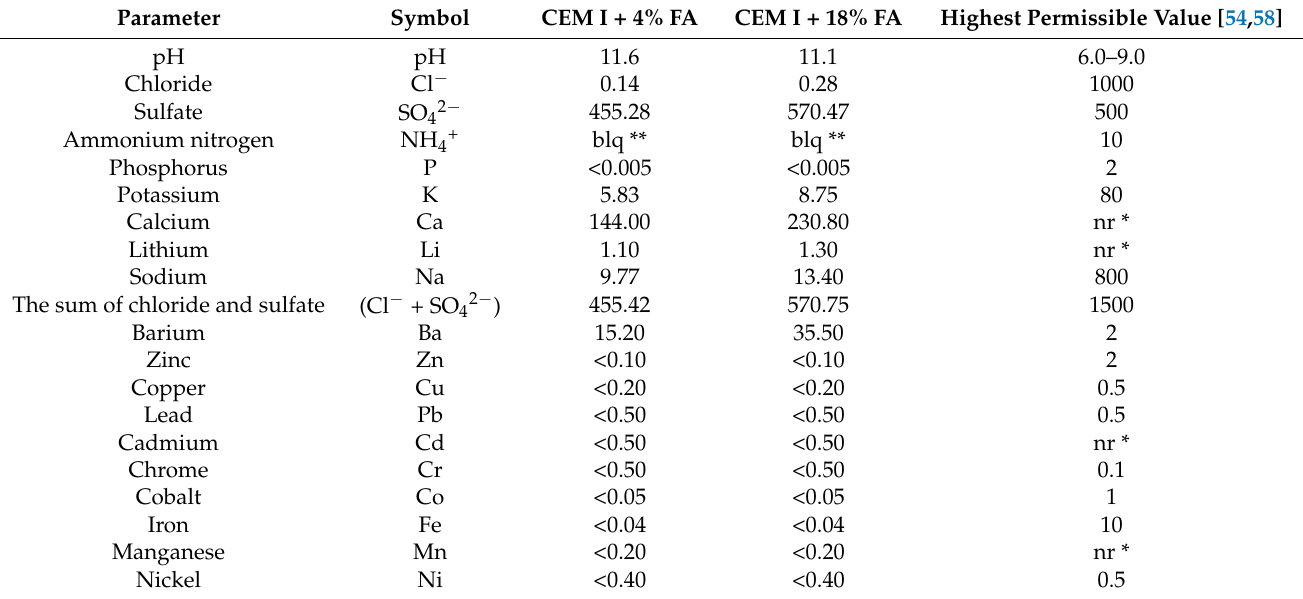
Table 5. The leachability of hazardous substances and heavy metals from cement mortars with the addition of fly ash, expressed in mg/L.